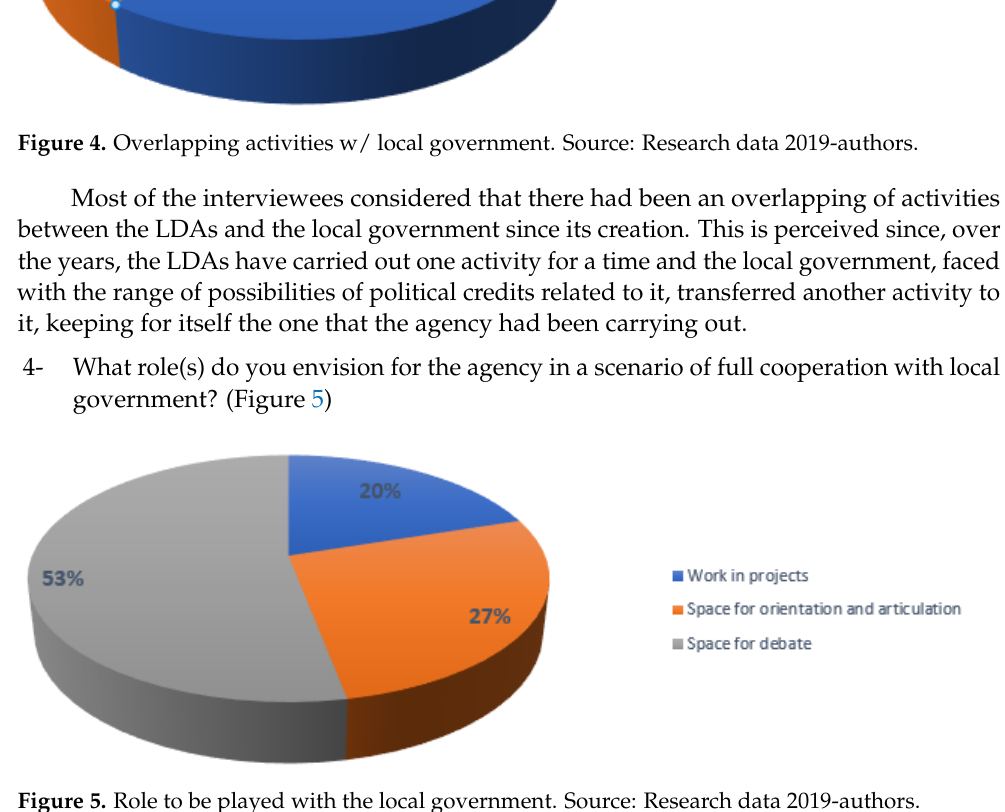
Figure 6. Possibilities for political dialogue. Source: Research data 2019-authors. If one considers the position of the Agency ’ s members in the territory, it believes in the possibility of a political dialogue with the local government. However, the more rad- ical political referents members of the LDAs do not agree. When questioned about how he perceives the coexistence of the agency with the gov- ernment, the local government representative clarified that since he entered the agency, he had always tried to work together with the LDAs. In fact, he stated that he assigned to the agency the possibility of working in the “ Dialogue for Employment ” and in other in- stances that seemed important for the agency. He also argued that the steering committee should be more active because not everything depends on the local government. He con- sidered that the role of the agency was fundamental because it gives continuity to public policies. He clarified that perhaps this was not noticed because the departmental govern- ment had been in the hands of a single party for almost 20 years and that gives it a certain logic of continuity, but it was not frequent. In a normal context, it is logical that, at the end of the period, the government team changed and the agency remained. That is why it was very important to have it in the territory and for it to be legitimized there. He believed that coexistence can and should be of total cooperation. This does not imply that at some point there will not be a struggle for space, for protagonism, but nothing that cannot be